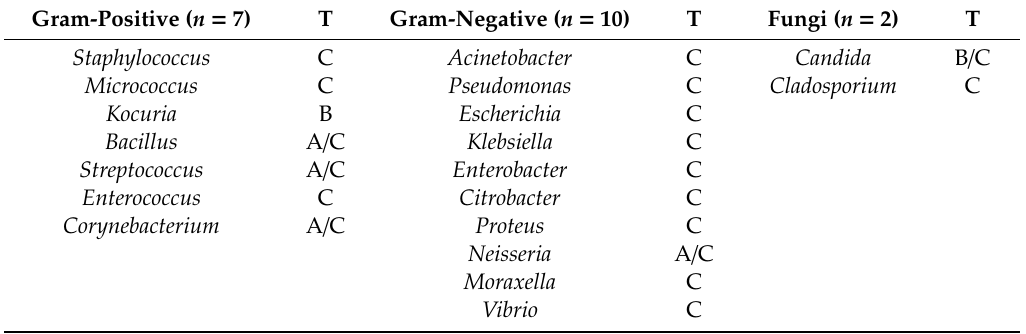
Table 3. Genera of healthcare-associated infectious organisms identified in the literature and their common route / s of